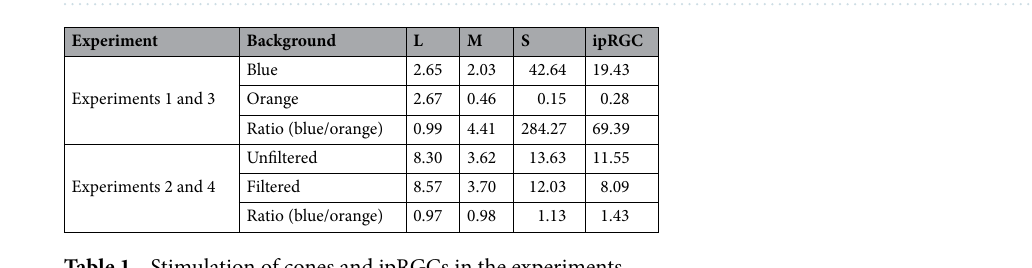
Table 1. Stimulation of cones and ipRGCs in the